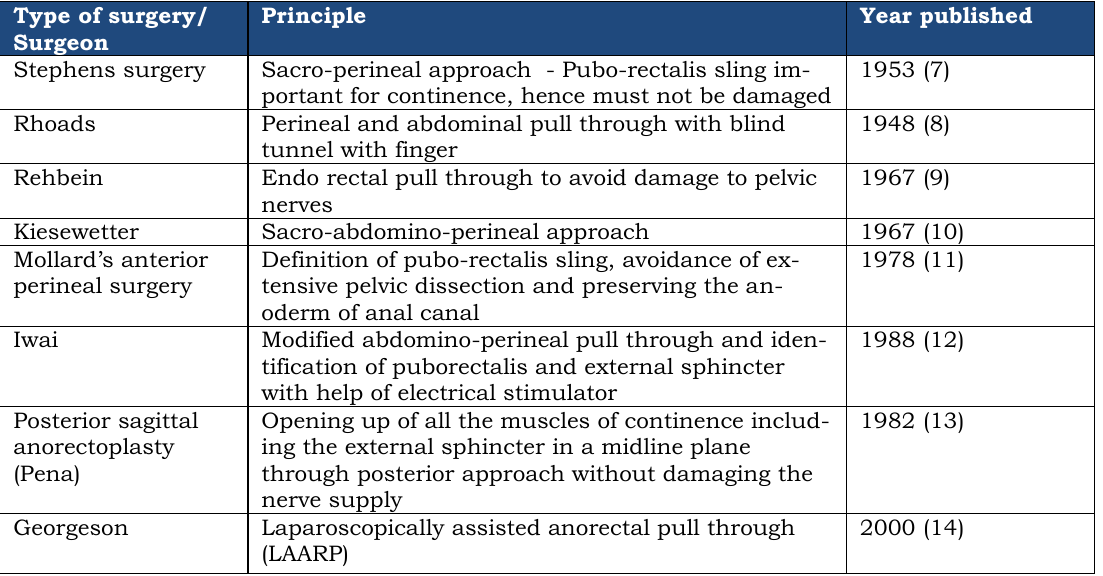
Table 4: Evolution of surgical treatment of Anorectal Malformations Type of